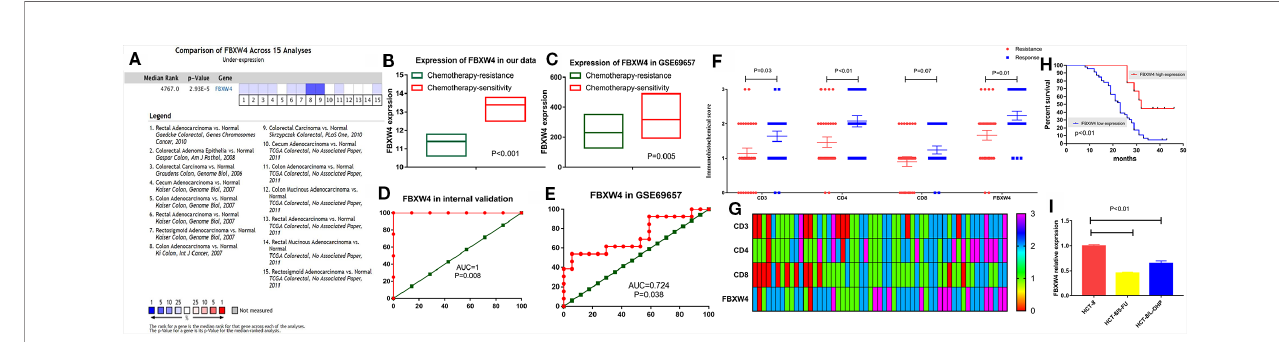
FIGURE 4 | Validation of FBXW4. (A) Meta ‐ analysis of 15 GEO ‐ sourced data sets mined from the Oncomine database showed that FBXW4 mRNA levels were signi fi cantly lower in CRC tissues than in normal colon tissues (P < 0.001). (B) In our data (11.40 ± 0.40 vs 13.38 ± 0.60, P = 0.000) and (C) GSE69657(231.13 ± 52.16 and 317.35 ± 102.57, P = 0.006). ROC curves and AUC statistics to evaluate the predictive ef fi ciency of the FBXW4 in our data and external data to distinguish chemotherapy-resistance from chemotherapy ‐ sensitive CRC cases from (D) our data and (E) GSE69657. The immunohistochemical score of FBXW4, CD3, CD4, and CD8 in FOLFOX-resistance and -sensitive cancerous tissue, (F) and (G). The overall survival for mCRC patients strati fi ed by the expression level of FBXW4 (H) . The FBXW4 expression in the FOLFOX resistance cell lines and parental cells